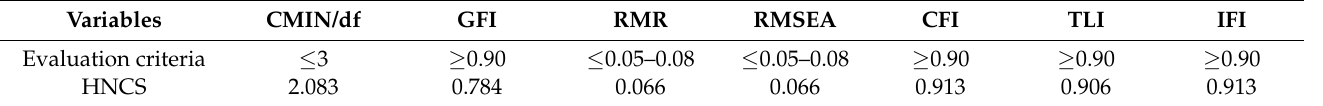
Table 3. Summary of fit indices from confirmatory factor analysis (N =